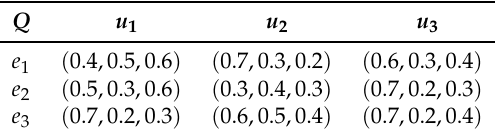
Table 2. Neutrosophic soft set p Q , M q